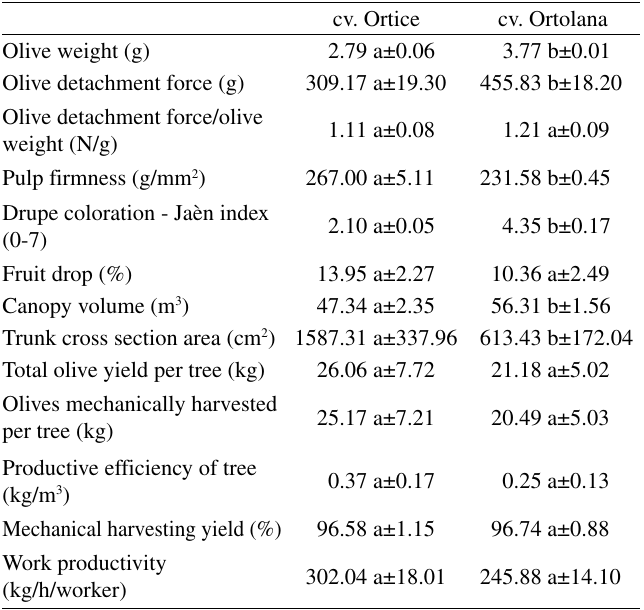
Fig. 1 - Mechanical harvesting of olives with a trunk shaker with a reversed umbrella interceptor.